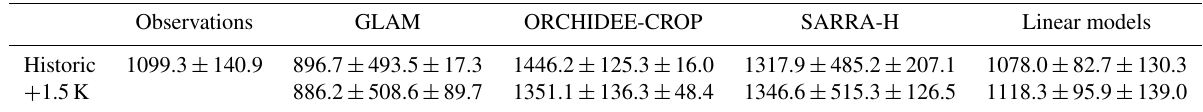
Table 3. Simulated maize yields (kgha − 1 ) in West Africa for observations and four crop models for the historic time period and at 1.5K. The first uncertainty value is the inter-annual variability and the second is the spread across the RCM–GCM ensemble.